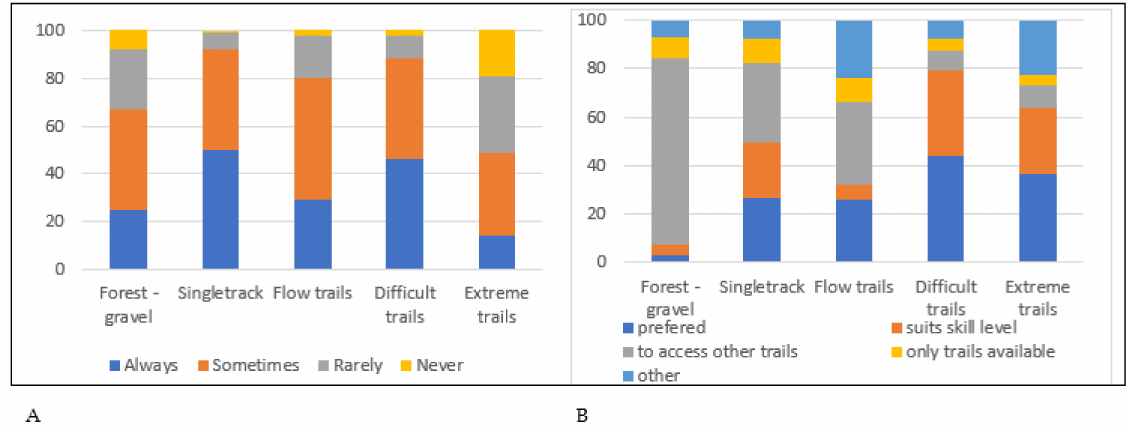
Figure 1. Self-reported use of different trail typologies: ( A ) frequency of trail use; ( B ) reason for trail